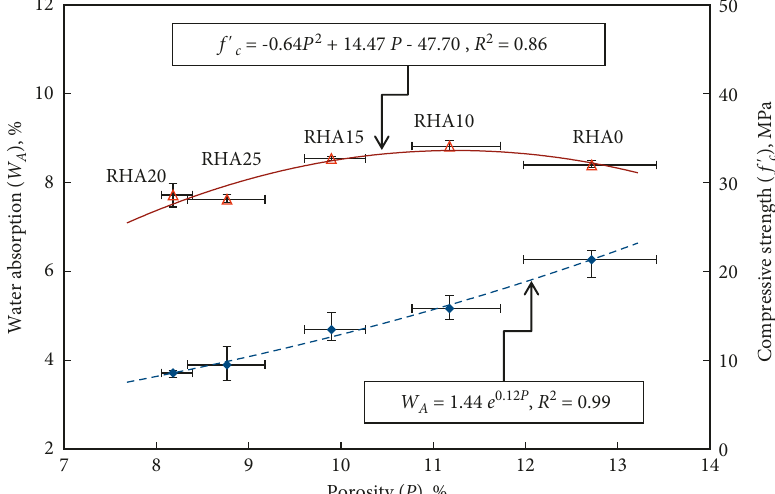
2 SO 4 solution for 30, 60, and 90